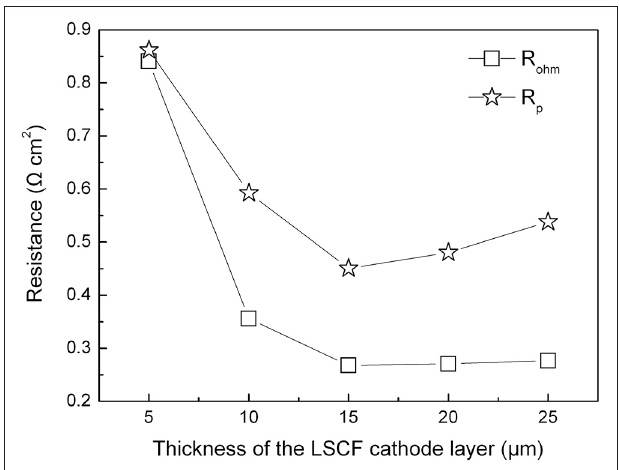
FIGURE 6 | Ohmic and polarization resistances of the tubular single cells with different cathode thicknesses at 800 ◦